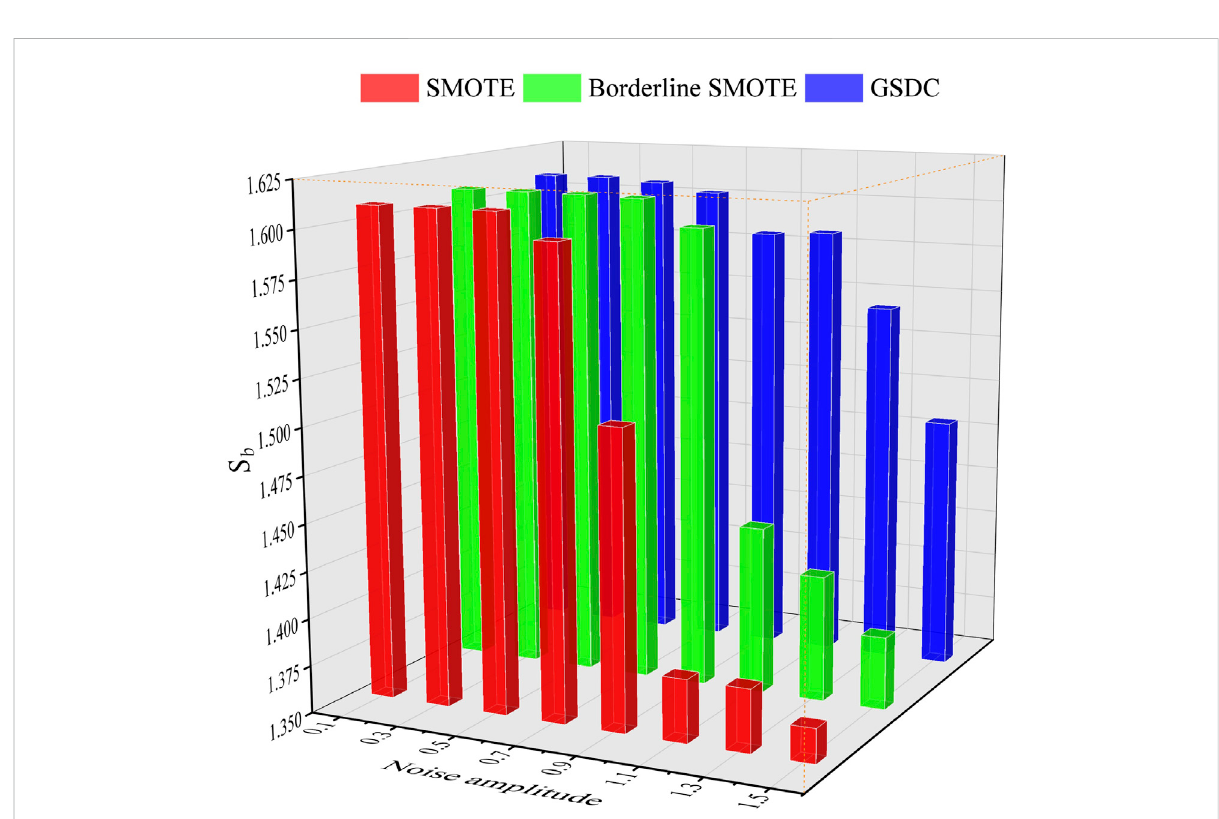
FIGURE 4 The values of S b based on different class balancing algorithms and different levels of noise.